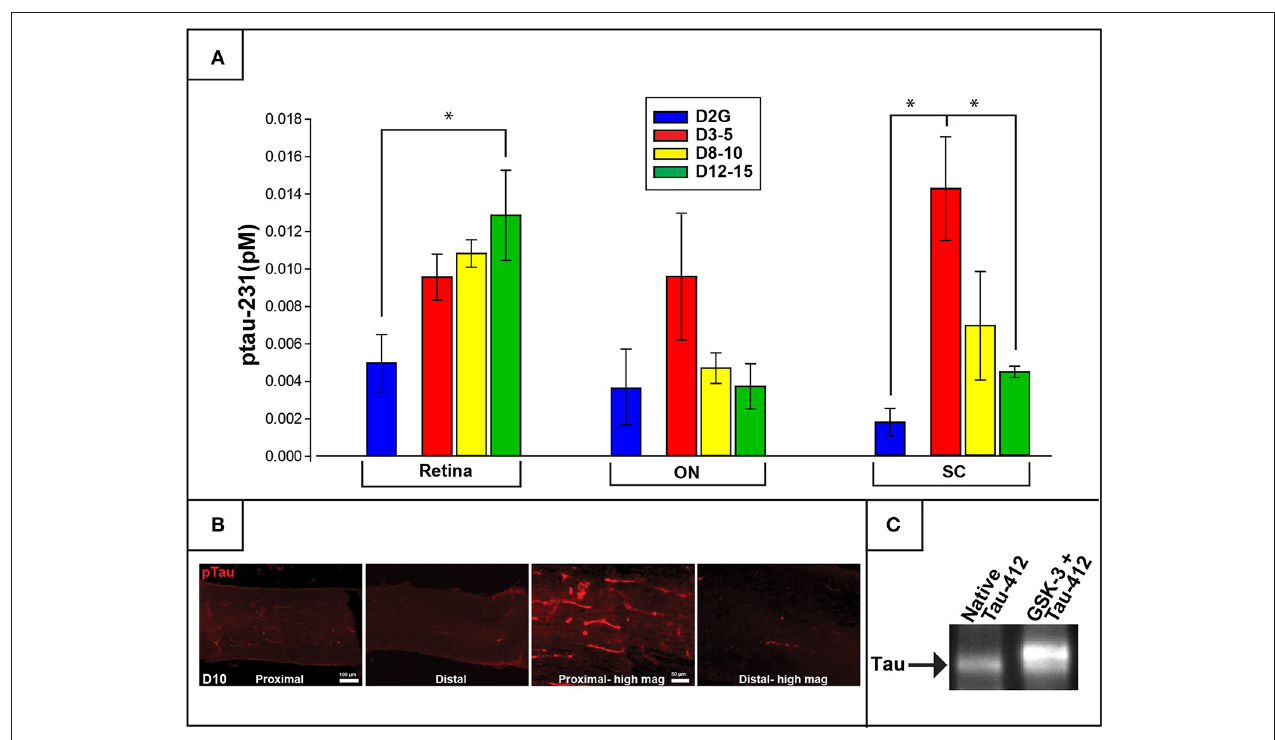
FIGURE 3 | Phosphorylated tau (ptau-231) is elevated early in the distal projection and is observed to translocate to the retina in pathologically-aged animals. (A) Multiplex quantification of ptau-231 in DBA/2J mice shows an age-dependent decrease of ptau in SC with an age-dependent increase in retinal ptau. In the SC, ptau-231 is significantly higher in the D3-5 group compared to D12-15 and D2G control group levels. In retina, however, D12-15 ptau-231 levels are significantly higher than D2G controls. Ptau levels in ON samples did not differ between groups. (B) Immunofluorescence for ptau-231 in 10-months. DBA/2J ON shows evidence of preferential accumulation of ptau-231 in the proximal portion compared to the distal portion of the nerve. (C) An example of co-immunoprecipitation data comparing native and hyperphosphorylated tau via reaction with GSK-3 suggests an increased affinity of phosphorylated tau for the retrograde motor component, dynactin-2. This is qualitatively illustrated by the increased optical density of Tau-5 (a marker for pan-tau) in the second lane representing hyperphosphorylated tau (GSK-3 + Tau-412), compared to the first lane which contained only native tau. The tau band shown here corresponds to a molecular weight of approximately 43.5 kDa corresponding to the GSK-3 phosphorylation site, pS396/404. Asterisk indicates that groups are significantly different from bracketed comparison ( p < 0.05). Error bars depict